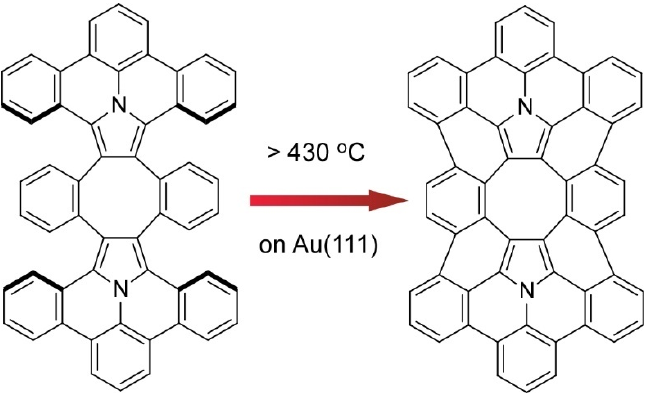
Figure 9. Synthesis of  -extended diaza[8]circulene through on-surface syntheses on a Au(111) surface.